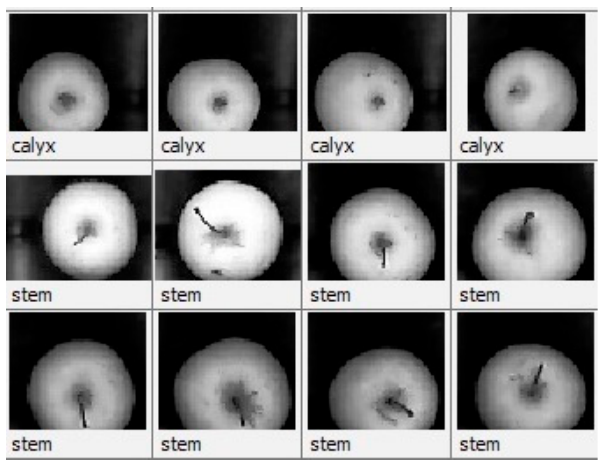
Figure 5. Results of training system with the definition of two classes by the k-NN classifier, k = 3, and Euclidean distance as the metric distance. Table 1. Classification rates for stem and calyx detection by NN, 3-NN, 4-NN, and 5-NN; 40 training samples and 80 training samples; and 3 metric distances: Euclidean (Eu), maximum (max), and Manhattan